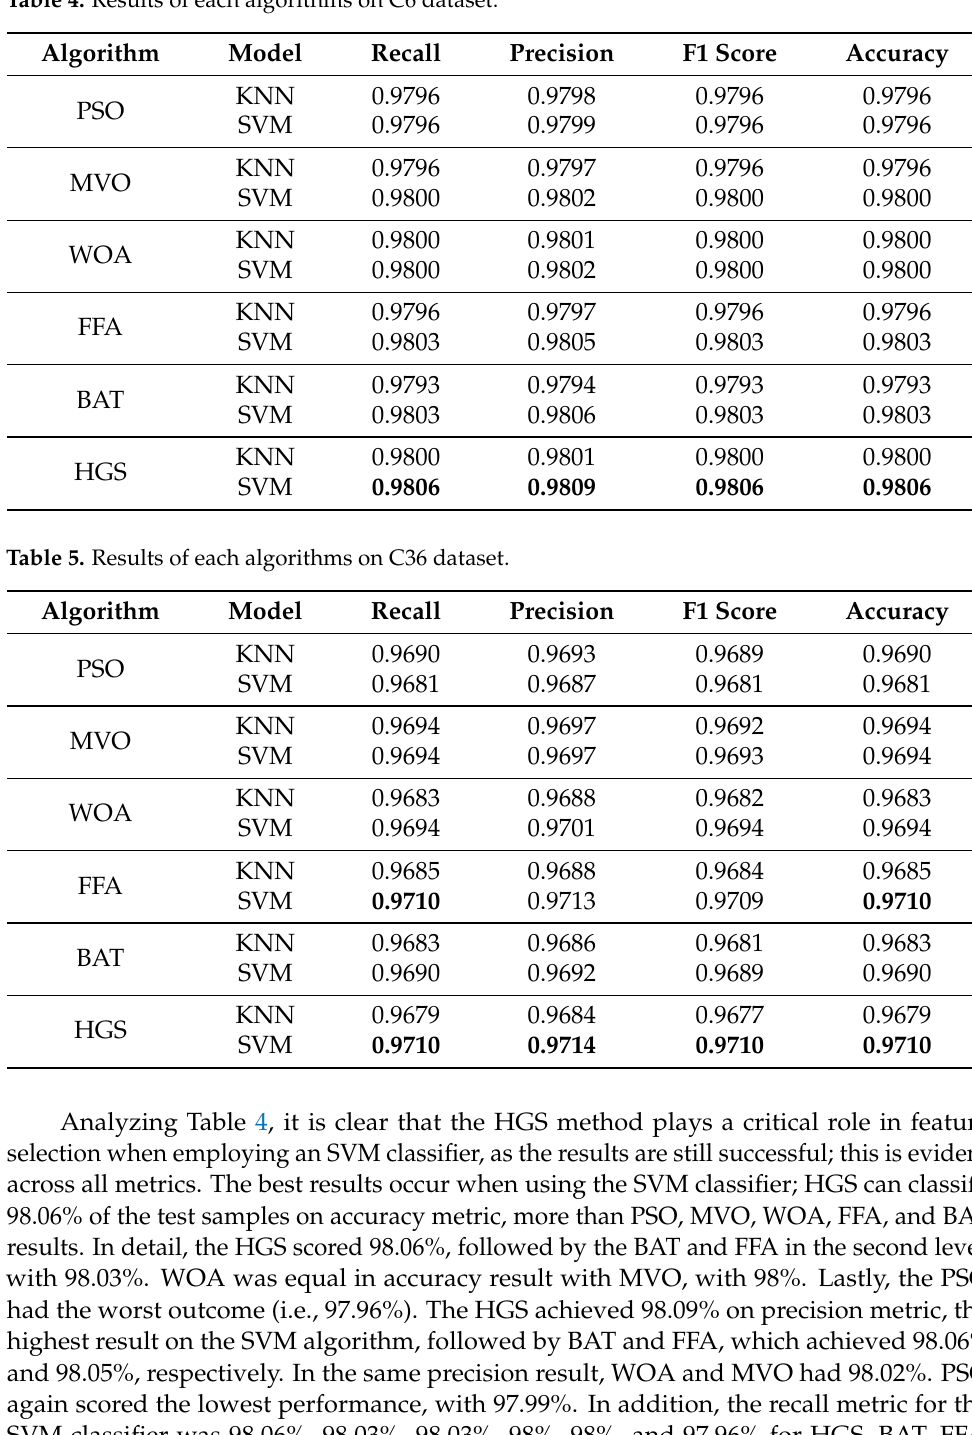
Table 4. Results of each algorithms on C6 dataset.